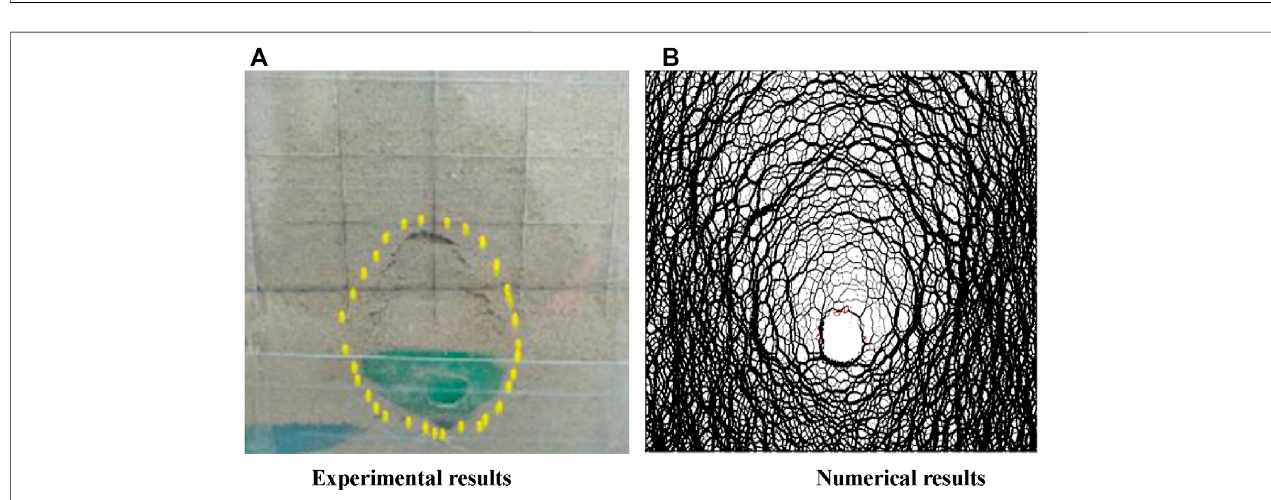
Frontiers in Earth Science |